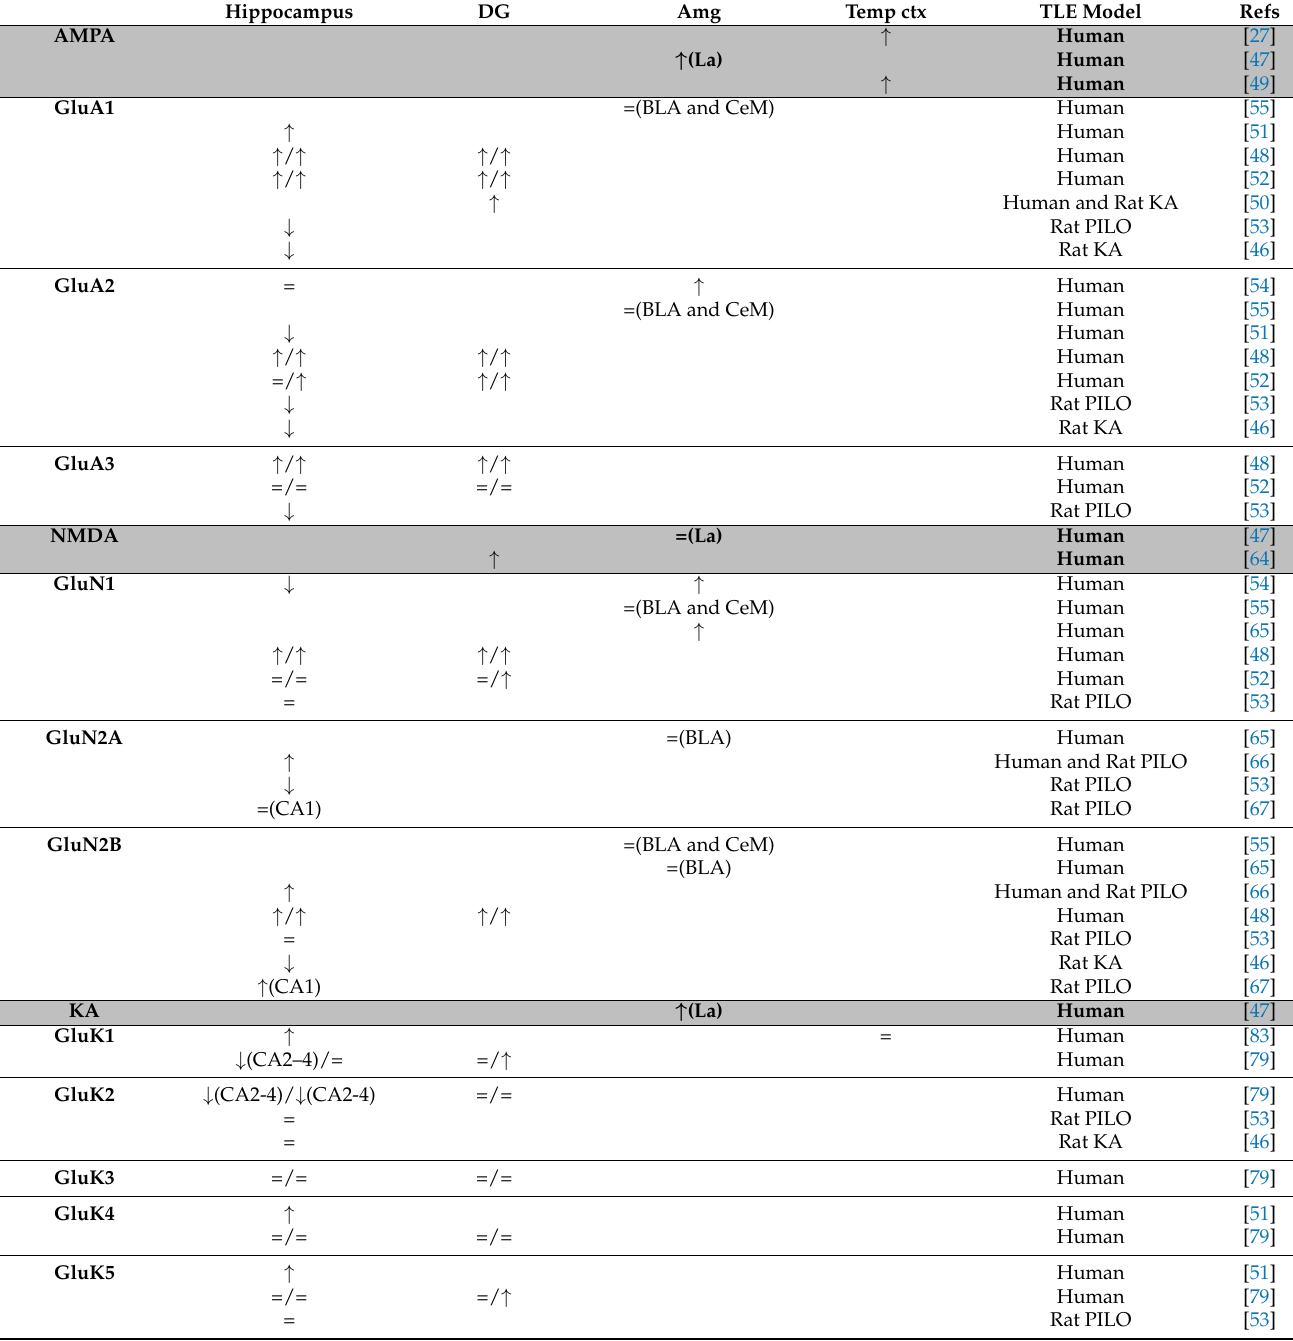
Table 1. Alterations of neuronal glutamatergic ionotropic